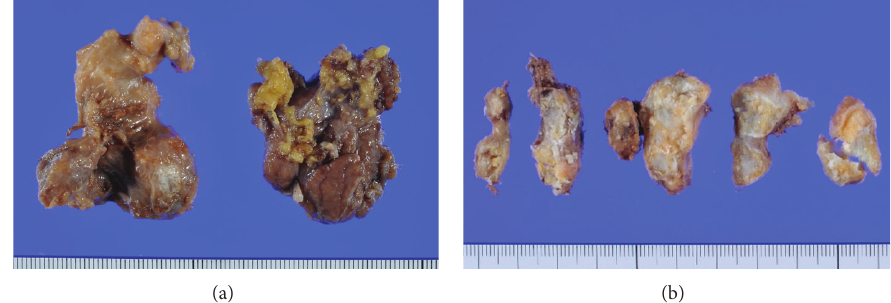
Figure 3: (a) Resected tumor was a 4 cm × 3 cm × 3 cm solid mass. (b) Cut surface. Lumpy calcification and ossification were noted.